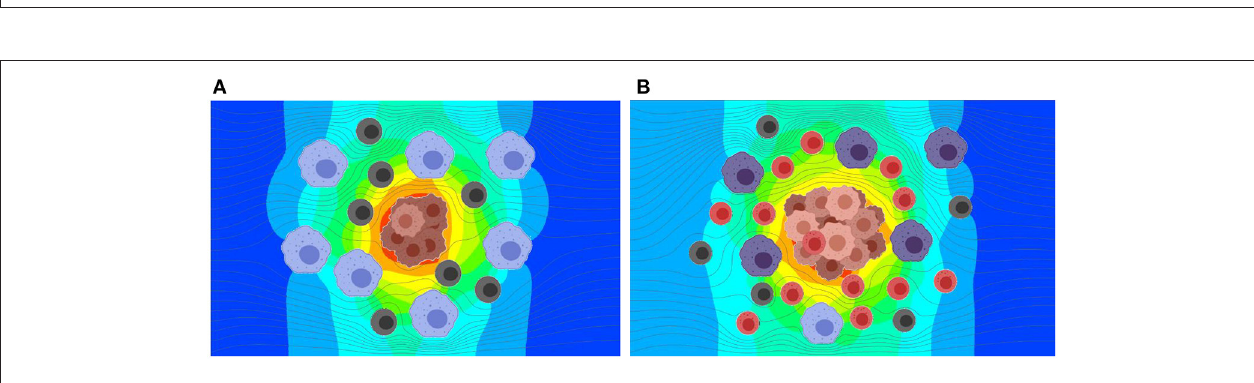
compared to the early stage, see Figure 7 . This could also lead to a higher rate of exosome release due to the larger mechanical forces acting on the tumor surface. However, in this simulation